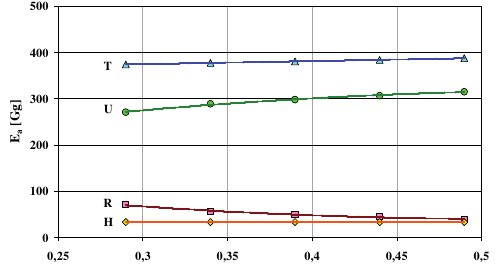
Fig. 5. Dependence of the national annual emission of particulate matter Fig. 1. Dependence of the national annual emission of carbon monoxide PM2.5 from tribological elements of passenger cars upon the road length from passenger cars upon the road length travelled under the following travelled under the following model traffic conditions: U – urban, R – model traffic conditions: U – urban, R – rural, H – on highways and rural, H – on highways and expressways and T – under all conditions expressways and T – under all conditions